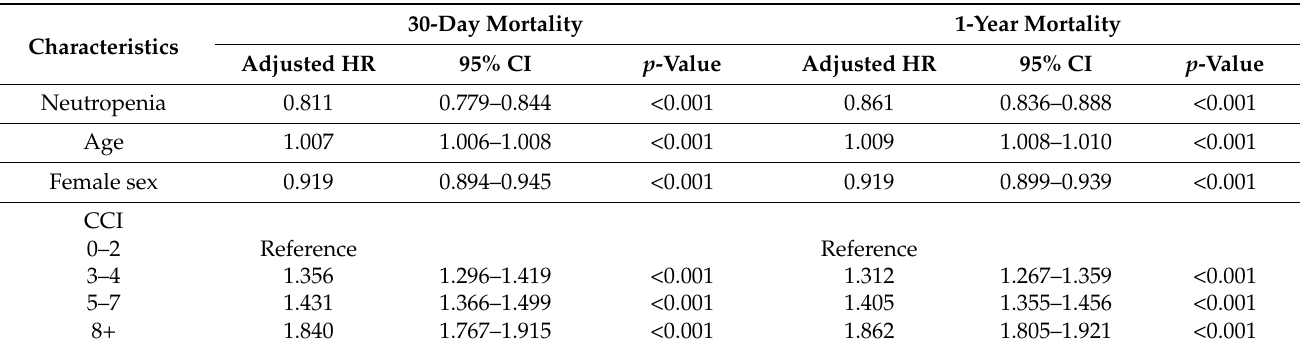
Table 2. Factors associated with 30-day and 1-year mortality in septic shock survivors according to multivariate Cox proportional hazard regression analysis.